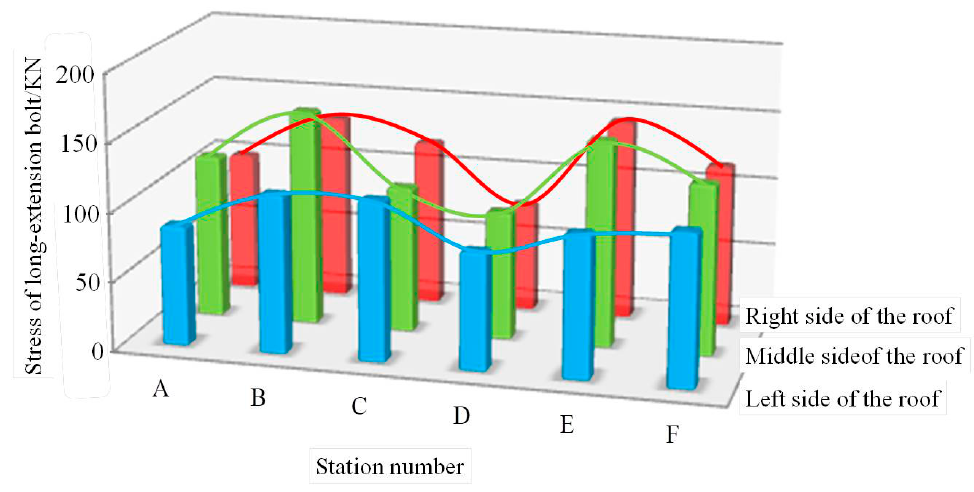
Figure 17. Monitoring statistics of long-extension bolt support force in the test roadway.